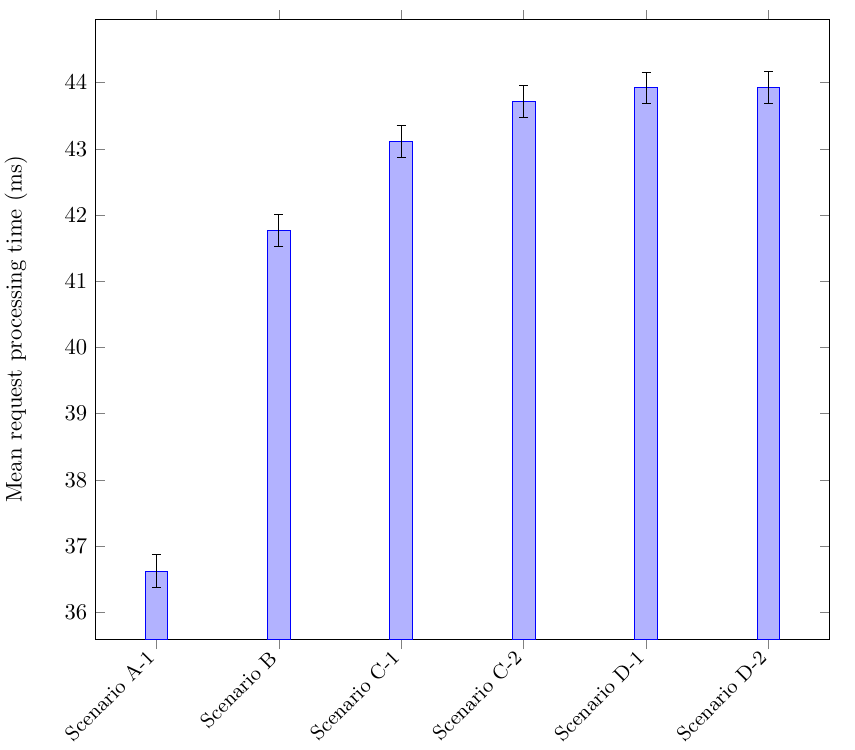
Figure 8. Request processing times for HotROD using different tracing scenarios. The two configura- tions corresponding to our solution are scenarios C-1 and C-2, while the baseline—tracing with Jaeger only—is scenario B. For reference, scenario A-1 corresponds to disabling all tracing. Scenarios D-1 and D-2 are two configurations for the fake syscall technique that we implemented for comparison. Table 2. Overhead of our trace collection solution for HotROD. The overhead of our solution compared to the baseline is below 4% when using the snapshot mode in LTTng and around 5% when using the standard mode.